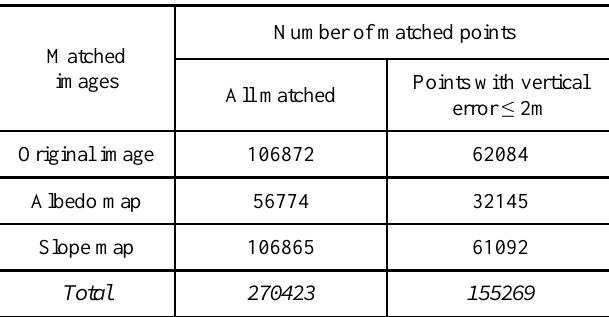
Table 9. Number of conjugate points for each image